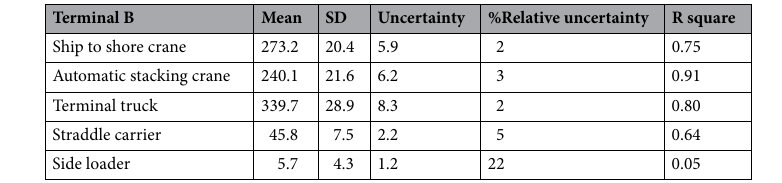
Table 5. Uncertainty results for terminal